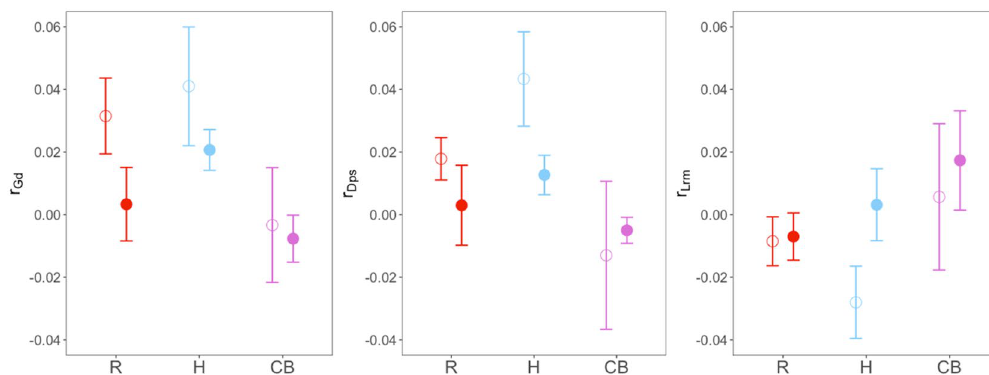
Figure 3. Mean and standard error for Mantel r coefficients computed between the matrix of genetic distances (calculated as Gd, Dps and Lrm) and the binary model (designed to separate the same and opposite sides of the barrier), controlling for the effect of Euclidean distances (see text for further explanation). Means are computed for plots belonging to each type of putative barrier (filled dots; R, H, CB) and compared to their control plots (empty